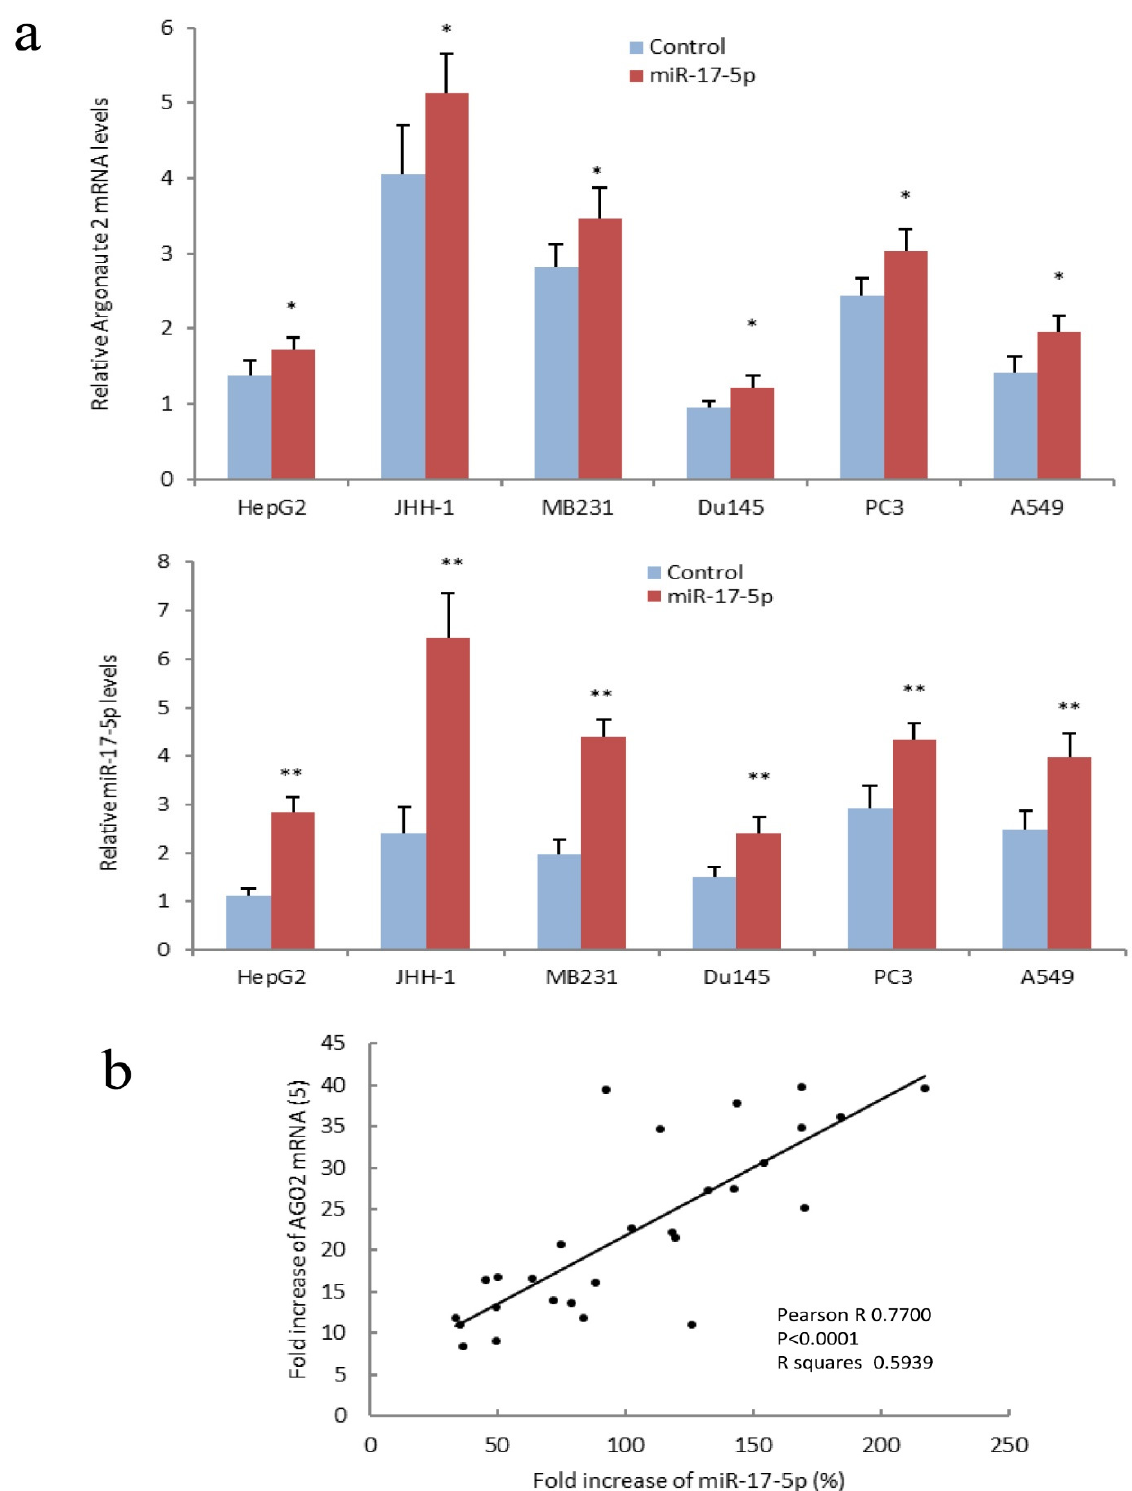
Figure 5. AGO2 expression increased in miR-17-5p transfected cancer cell lines. ( a ) Upper, RT-PCR showed that AGO2 expression increased in miR-17-5p transfected HepG2 cells. Lower, expression of miR-17-5p expression in above-transfected cell lines. * p < 0.05, ** p < 0.01 vs. control; Error bars, SD; n = 5. ( b ) Pearson correlation between fold increase of AGO2 mRNA and miR-17-5p in above miR-17-5p transfected cells was analyzed by Prism 8. Fold increases in AGO2 mRNA were positively correlated with increased miR-17-5p levels. Pearson R = 0.7700; p < 0.0001; n = 28.4.